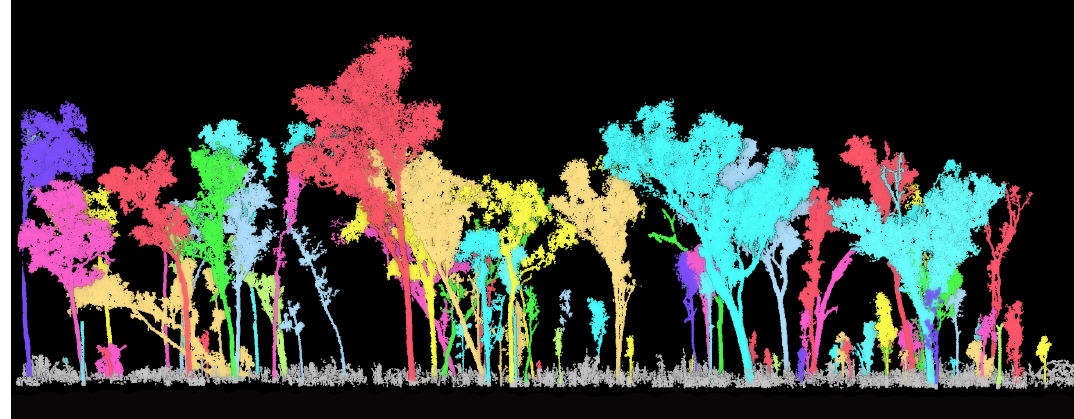
Figure 3. Cross-section through the TLS point cloud, displaying an example of the individual tree segmentation. Color scheme is a randomised palette.